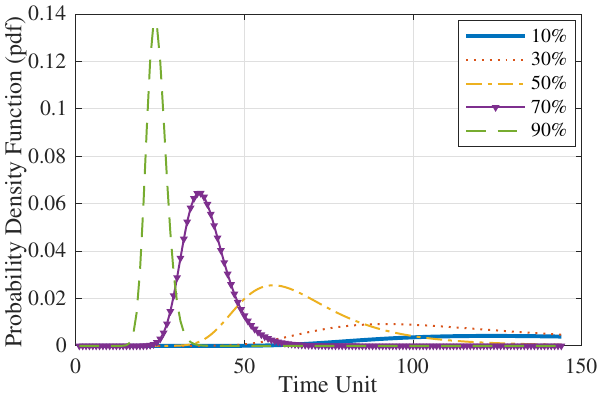
Figure 5. Updated RMFOP distributions of one validation switch system using the linear